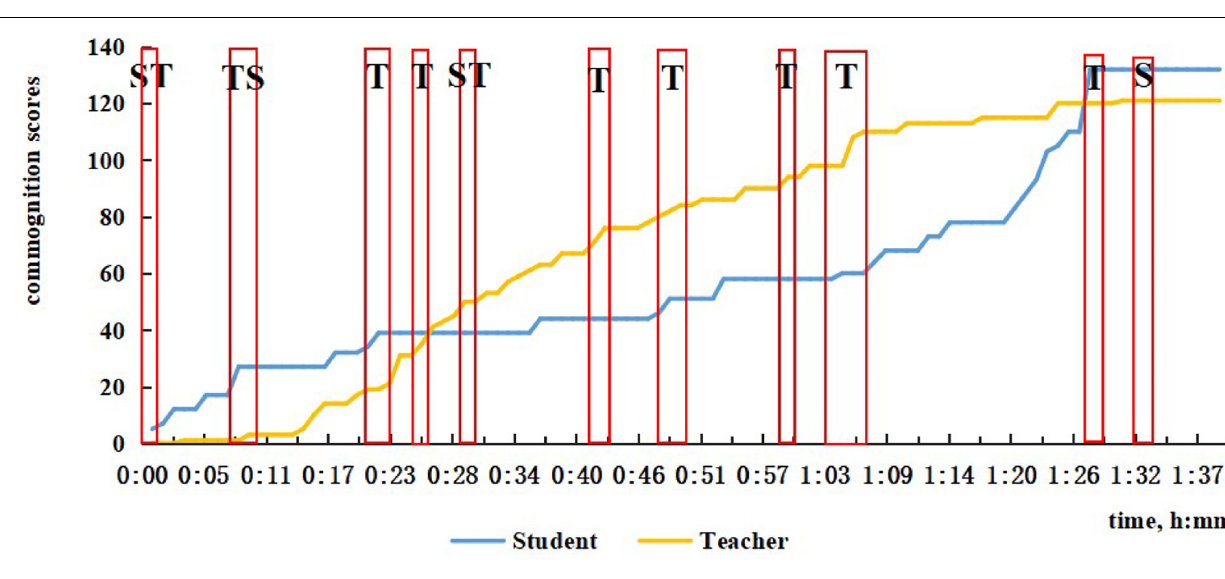
FIGURE 5 | Time periods and commognitive responsibility shift of CPS in Session